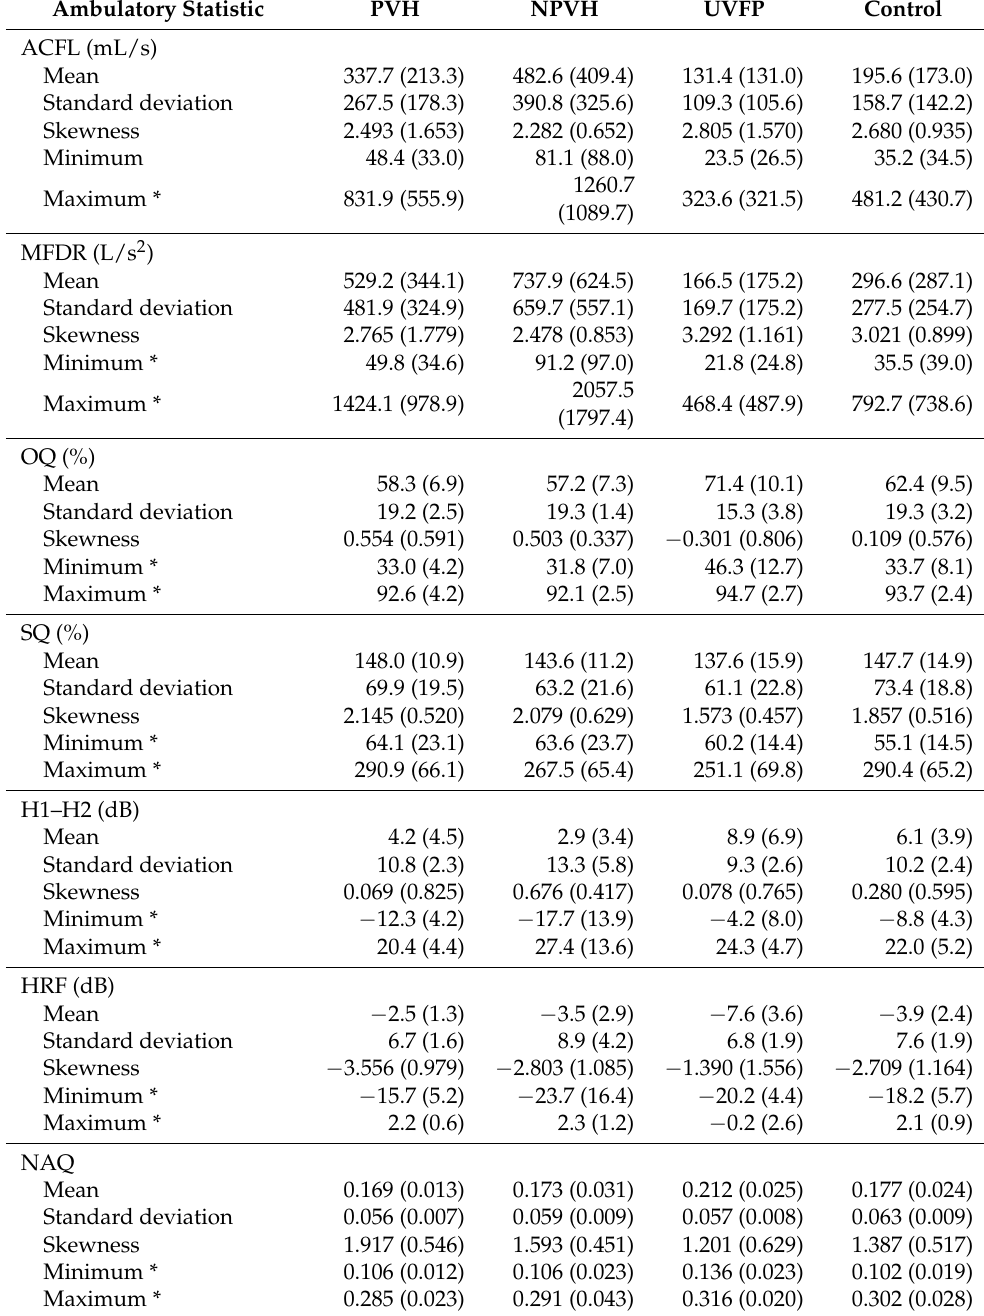
Table 8. Univariate statistics of daylong ambulatory estimates of glottal airflow measures for each participant group: peak-to-peak glottal airflow (ACFL), maximum flow declination rate (MFDR), open quotient (OQ), speed quotient (SQ), the difference between the first two harmonic magnitudes (H1–H2), harmonic richness factor (HRF), and normalized amplitude quotient